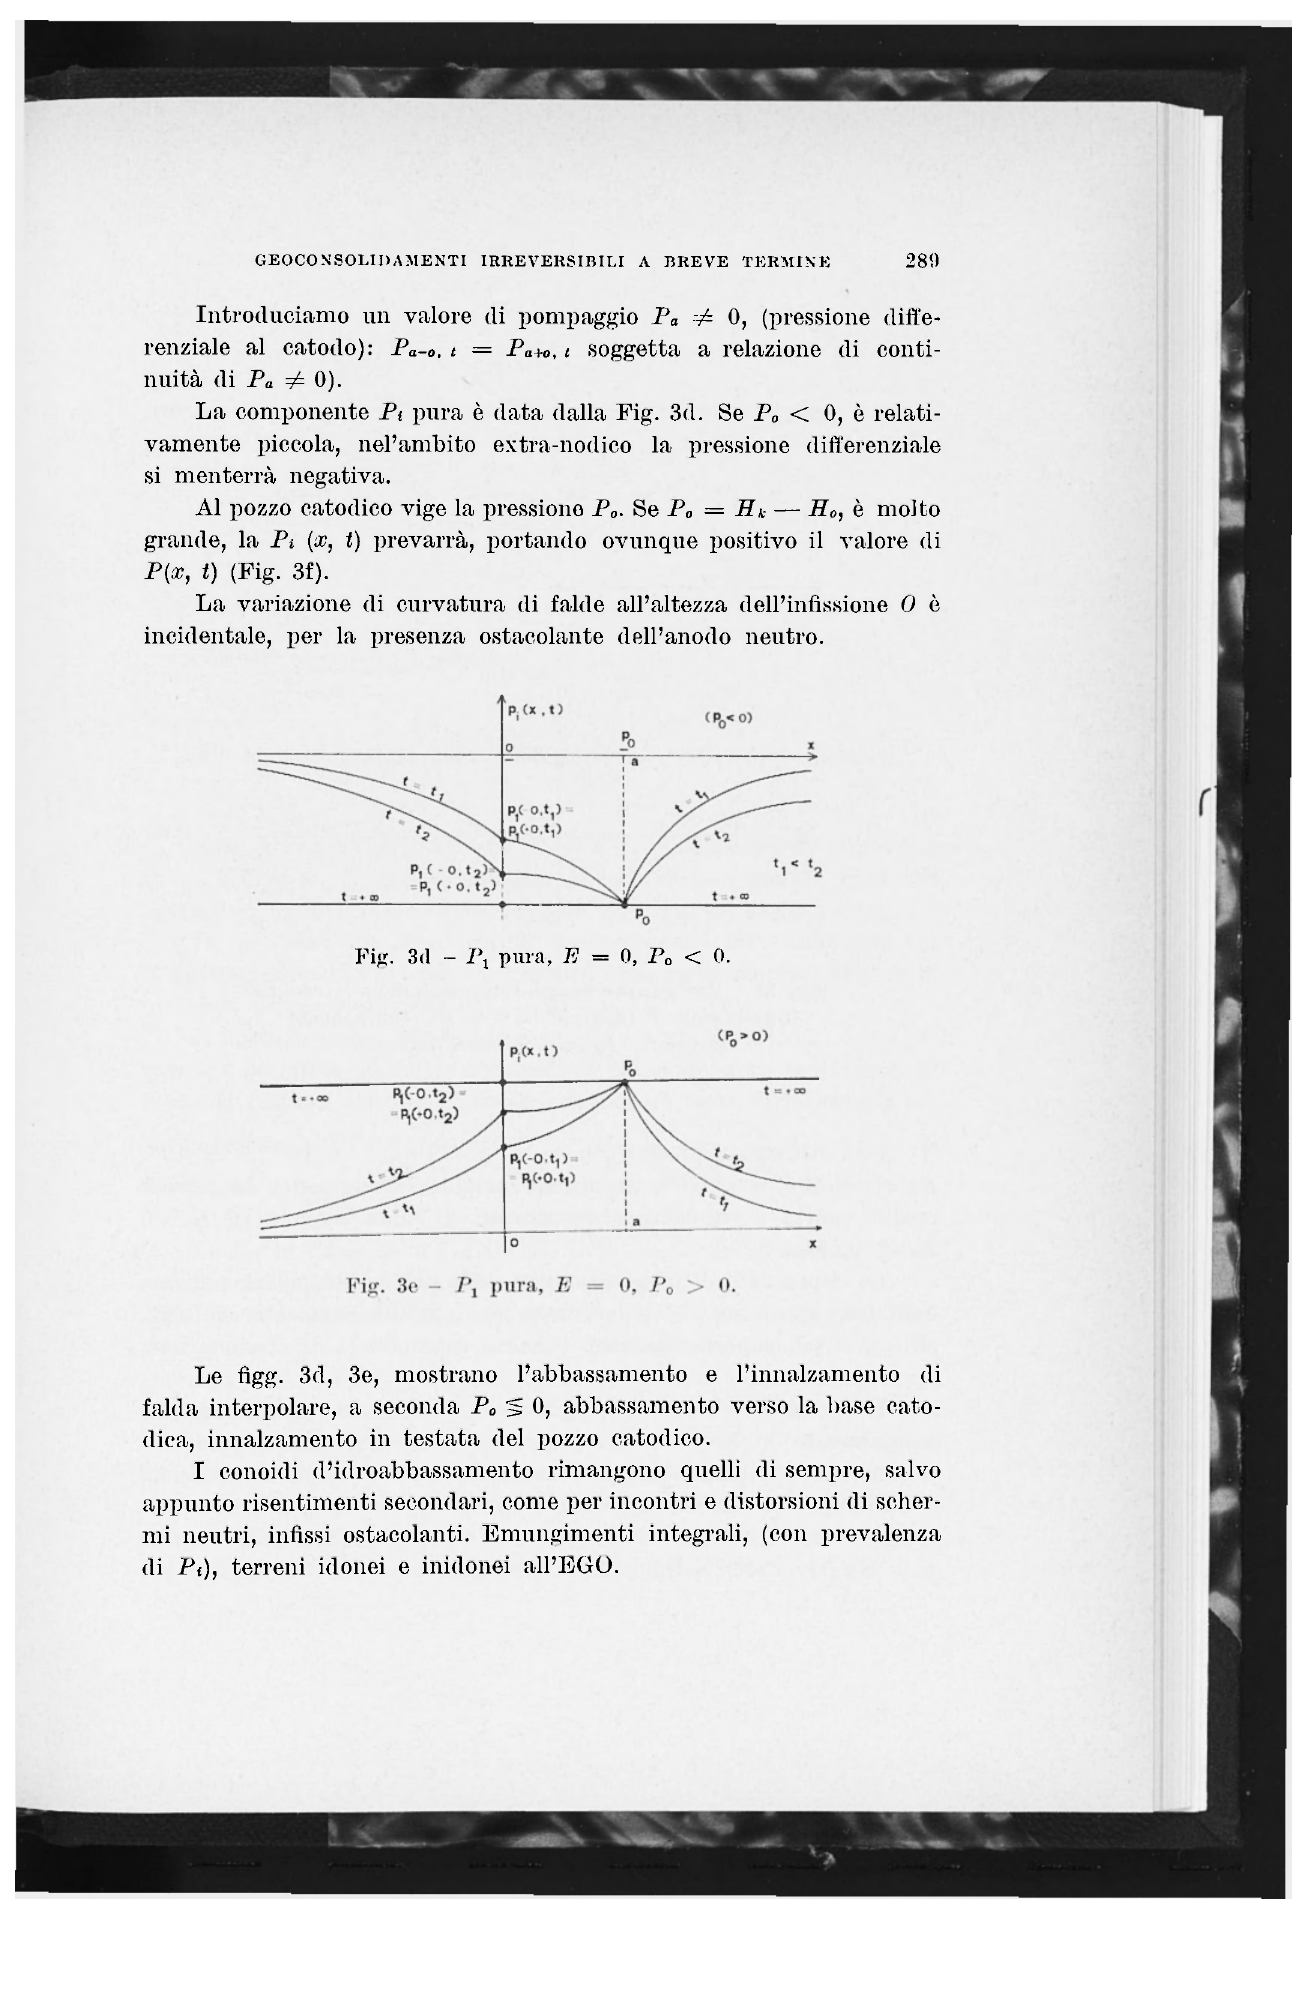
Fig. 3d - P t pura, E = 0, P„ <